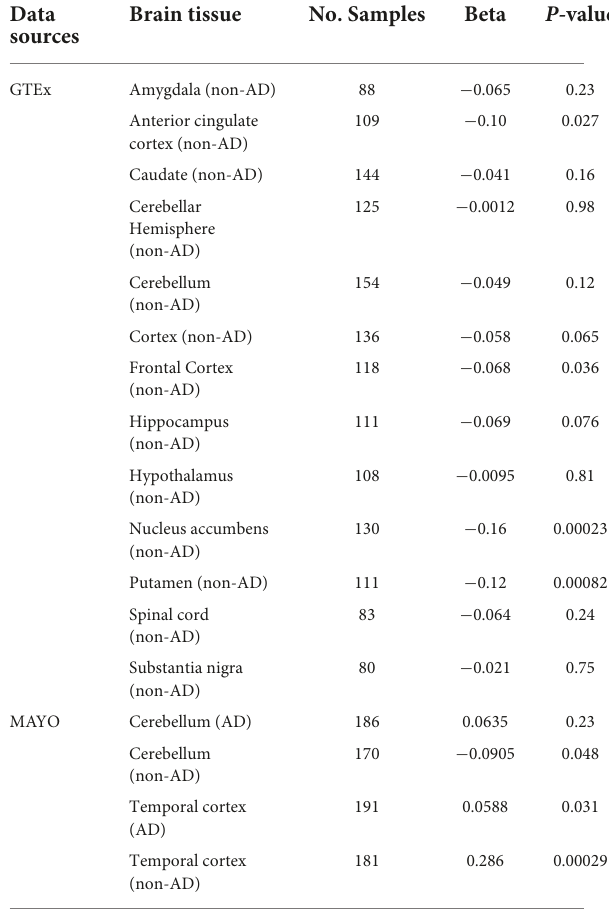
TABLE 2 The effect of genetic variant rs11136000 on CLU expression in AD and normal